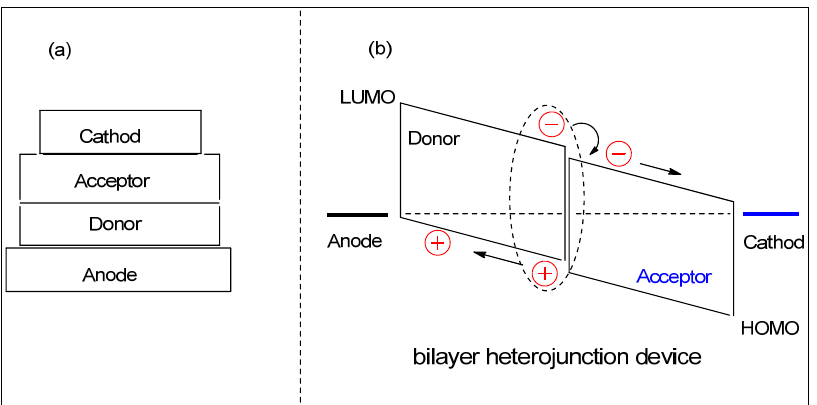
Figure 8. ( a ) Schematic of a bilayer organic structure. ( b ) Schematic of the phase separation of a bilayer device. The donor contacts the higher-work-function electrode and the acceptor contacts the lower-function